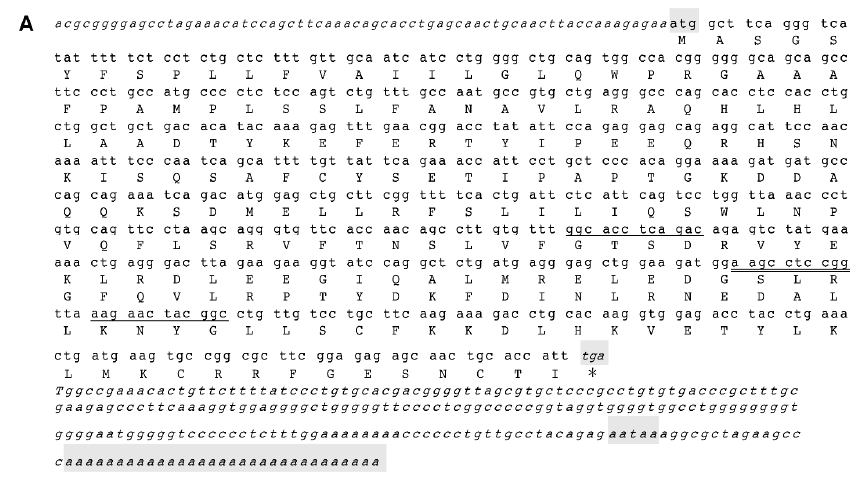
Figure 2. Cont. Figure 2.